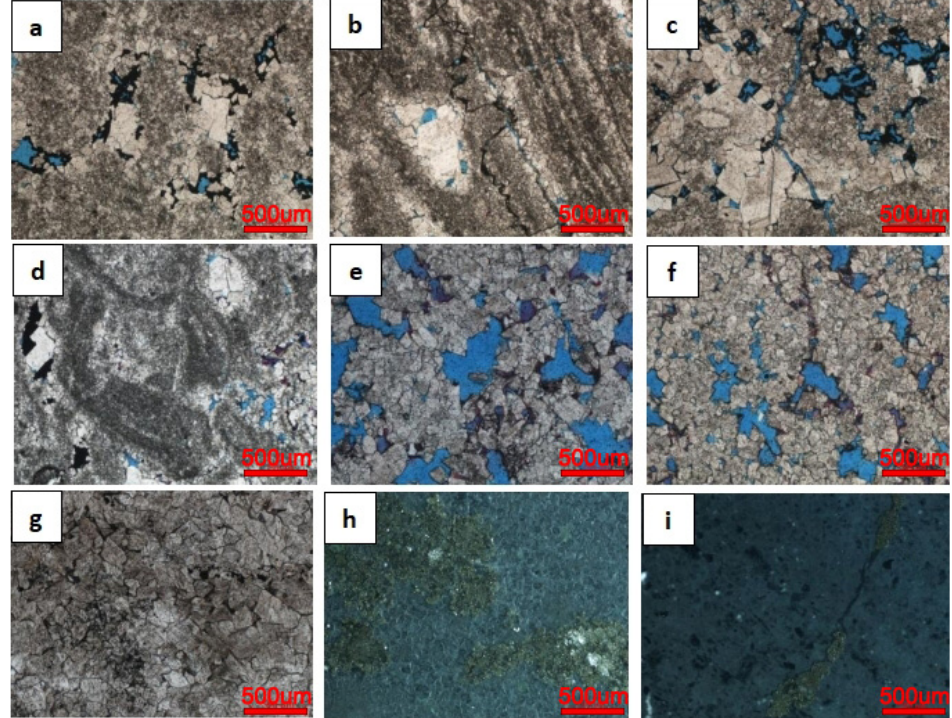
Figure 2. Photos of cast thin sections of cores in Well Shutan 1: ( a ) 1883.5 m, dolomicrite, hydrocarbon charged and adhered to the pores in wall; ( b ) 1884.85 m, algal straticulate dolostone, sutures filled by hydrocarbon and cut by microfractures; ( c ) 1886.2 m, crystal powder dolomite and mesocrystalline dolomite, hydrocarbon-filled intergranular dissolution pores of mesocrystalline dolomite; ( d ) 1887.6 m, fine crystal dolomite on the left, disorderly distribution of algal debris in the center, fine crystal powder dolomite on the right, intergranular pores completely filled with hydrocarbon on the left side, only a few hydrocarbons on the right; ( e ) 1916.1 m and ( f ) 1918.35 m, fine crystalline dolomite, abundant intergranular dissolution pores, contains bitumen; ( g ) 1990.1 m, densified silty dolomite, crude oil disseminated in intragranular and intergranular pores; ( h ) 1993.9 m and ( i ) 2058.4 m, dense dolomite, pyrite densely developed.